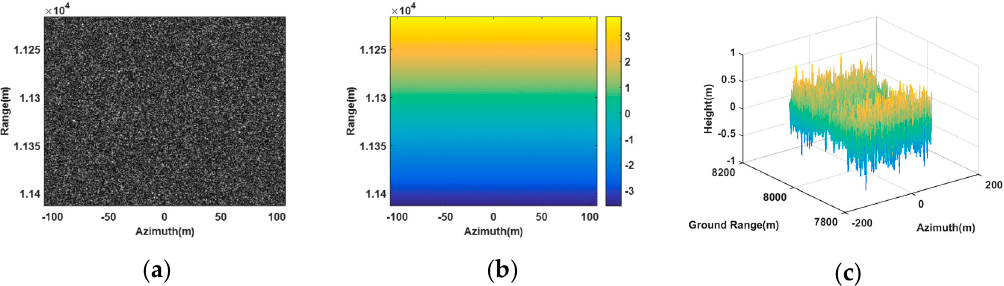
A . ( b ) Absolute interferogram after 1